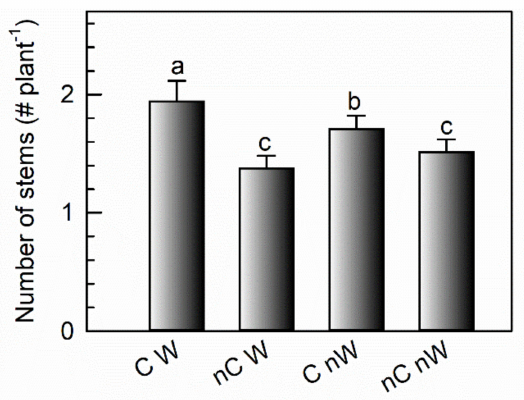
Figure 4. Number of stems sprouting from a single stool, counted after one season of growth since cutback in Salix sachalinensis . C and nC represent with and without cutback; W and nW represent with and without weed control, respectively. The significance values of the factorial analysis are shown in Table S1. Di ff erent letters indicate significant di ff erences in the corresponding values at p < 0.05. Values shown are mean ± SE from two clones of the same